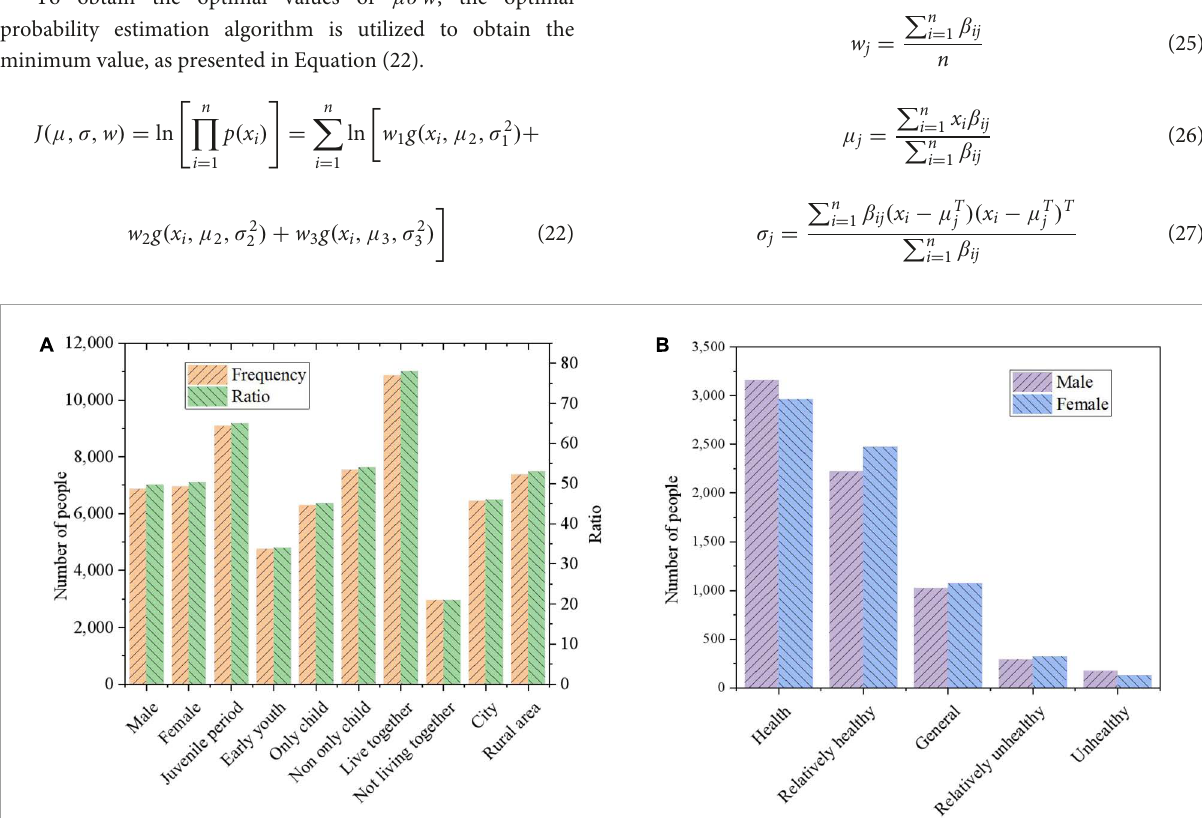
To obtain the optimal values of µσ w , the optimal probability estimation algorithm is utilized to obtain the minimum value, as presented in Equation (22).